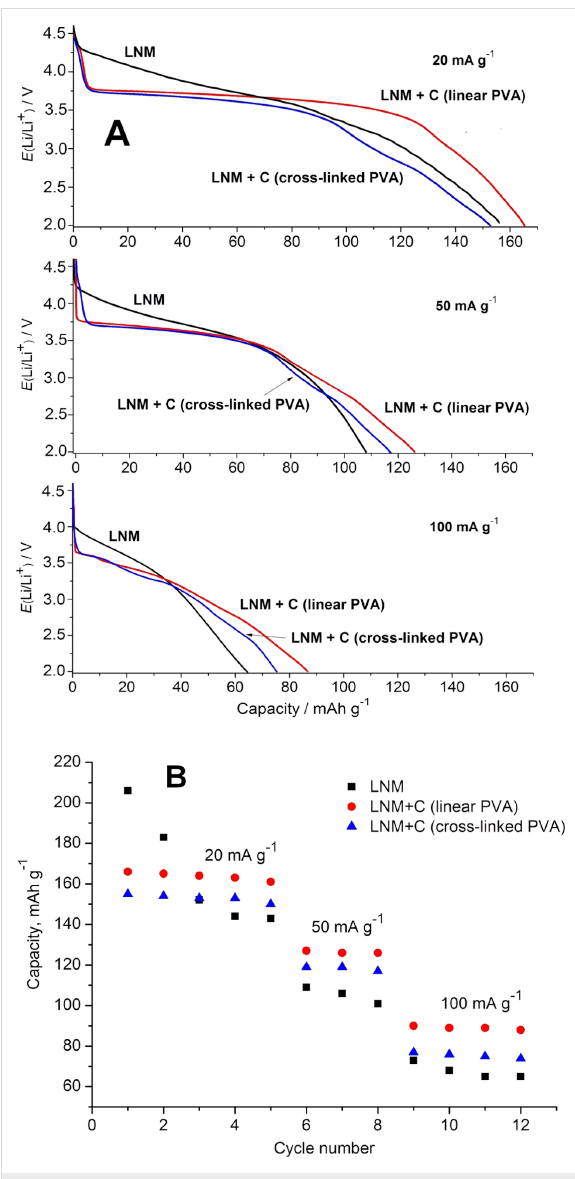
Figure 7: Discharge curves ( А ) and specific capacities ( В ) of pure Li 1.4 Ni 0.5 Mn 0.5 O 2+ x and LNM/C nanocomposites at discharge currents of 20–100 mA·g − 1 .